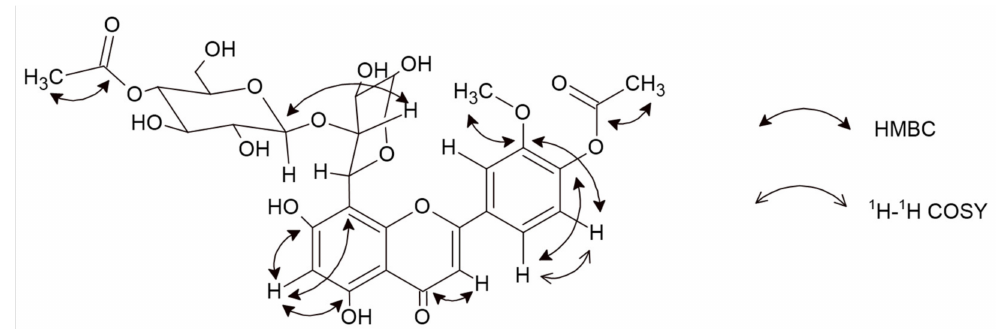
Figure 2. Important 1 H– 1 H COSY and HMBC correlations for compound 6